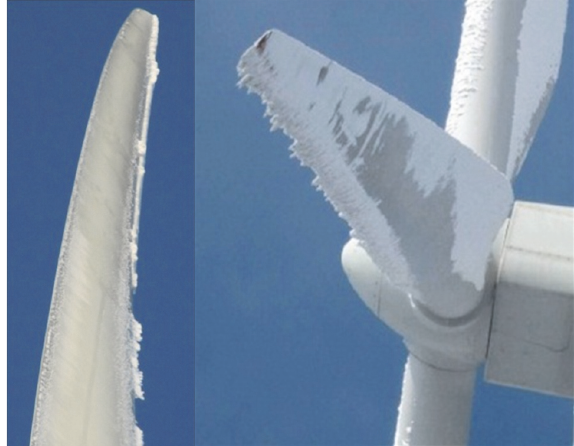
Figure 4: Ice on turbine blade [13, 14].